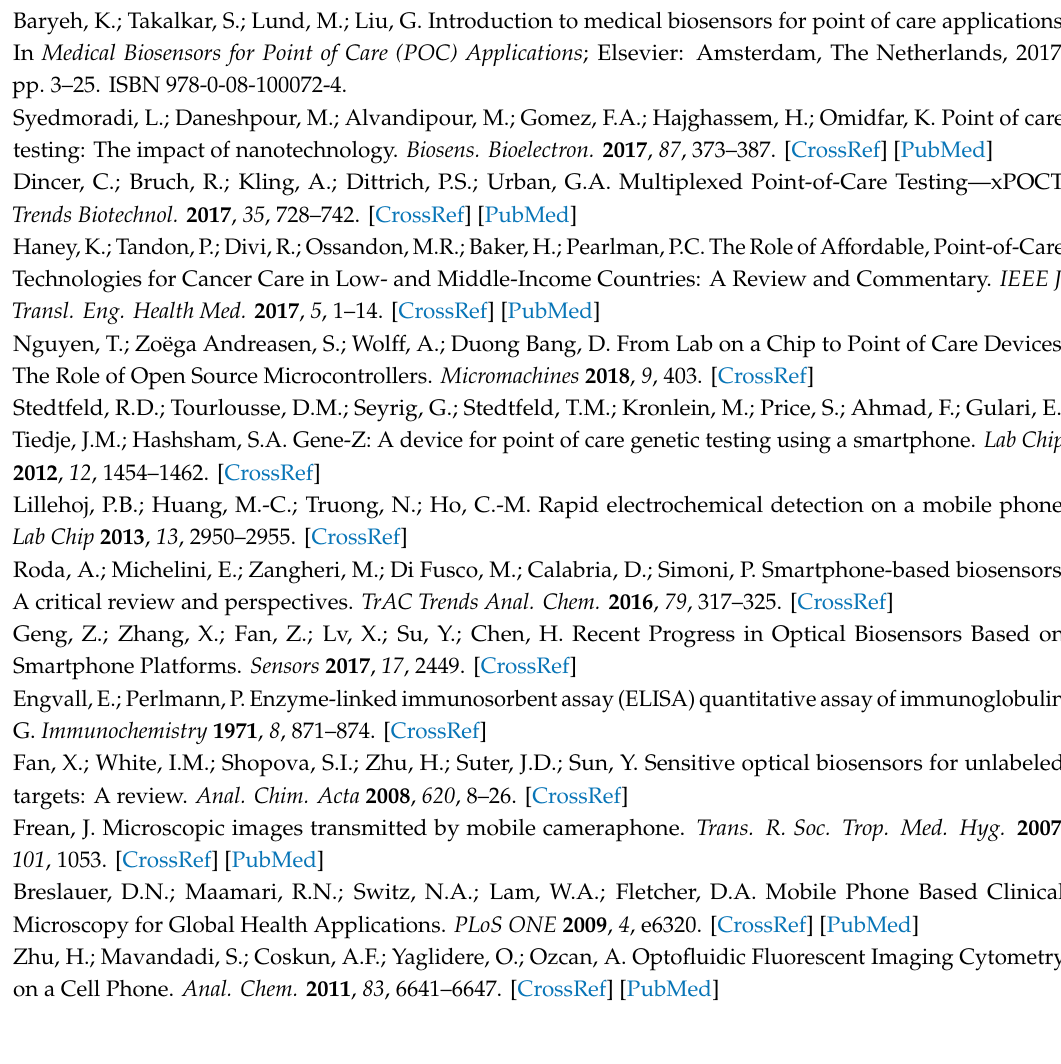
Table S1: Information regarding materials, chemicals, biologicals, and components; Figure S1: Workflow of the Python program during image analyzation; Table S2: The spectral calibration results of all channels; Figure S2: View of master mode on the smartphone; Figure S3: An example of